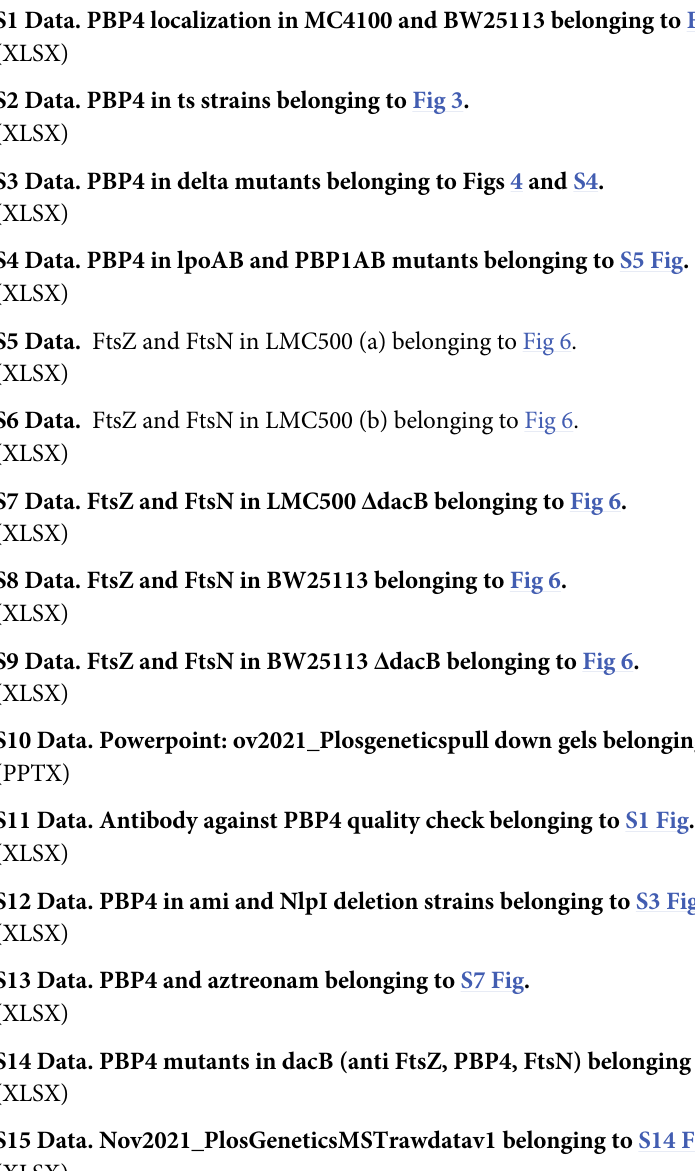
S2 Table. Phenotypes of dacB , amidases and regulators